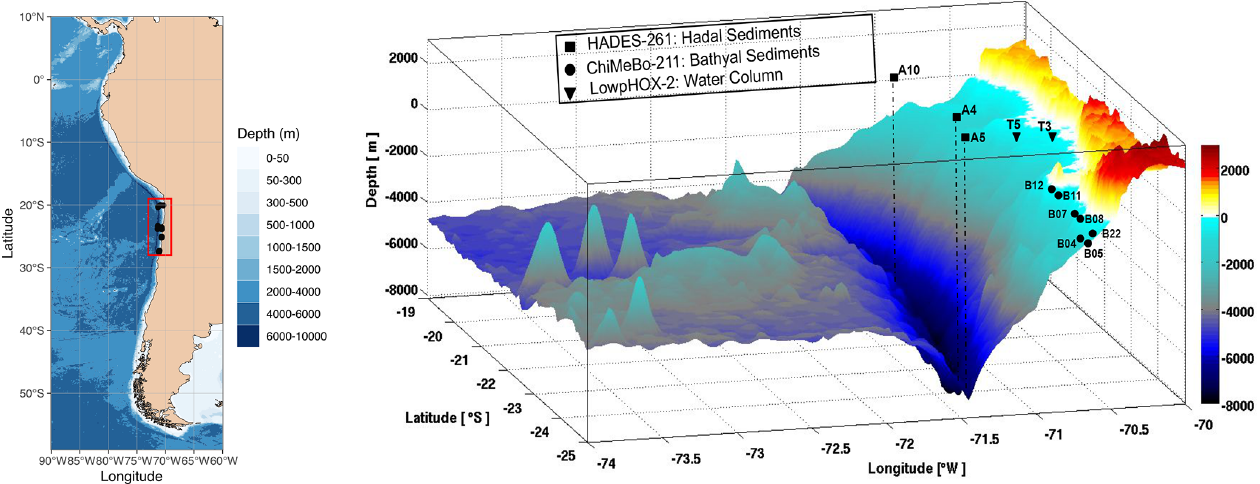
Figure 1. Three-dimensional map of the Atacama Trench showing the sampling locations of this study. The black squares indicate the hadal sediment sampling stations, the black circles indicate the bathyal sediment sampling stations from Matys et al. (2017), and the black triangles indicate water-column sampling stations from Cantarero et al.